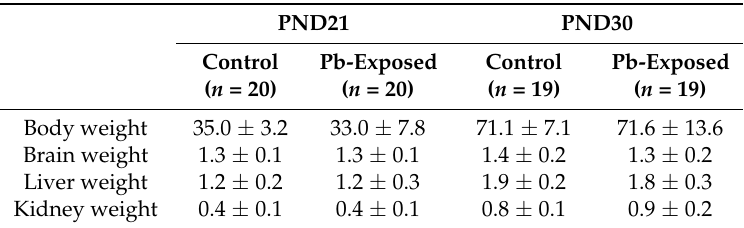
Table 2. Mean ( ± SD) body and tissue weight (g) of control and Pb-exposed Wistar rat pups at PND21 and PND30.